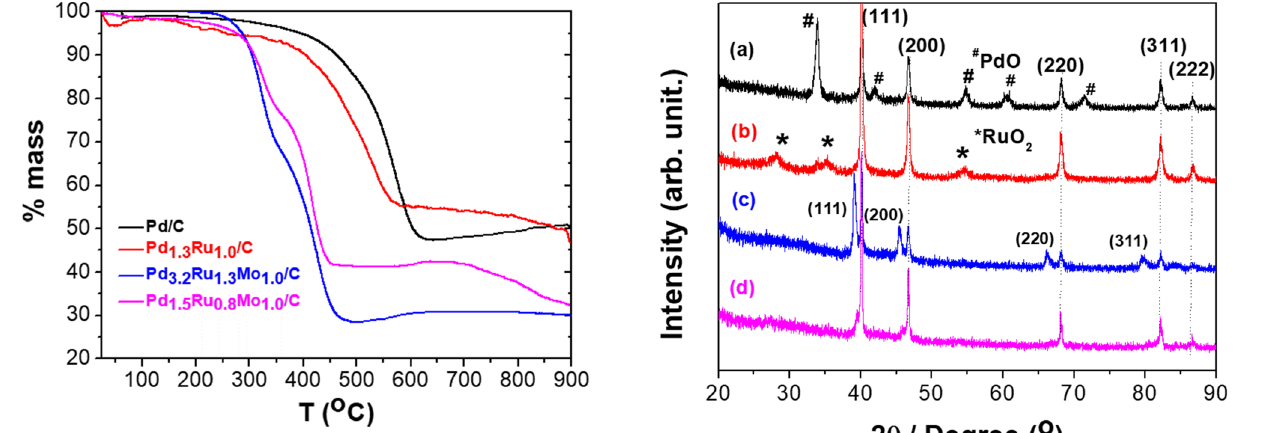
1.3 Ru 1.0 /C, c Pd 3.2 Ru 1.3 Mo 1.0 /C